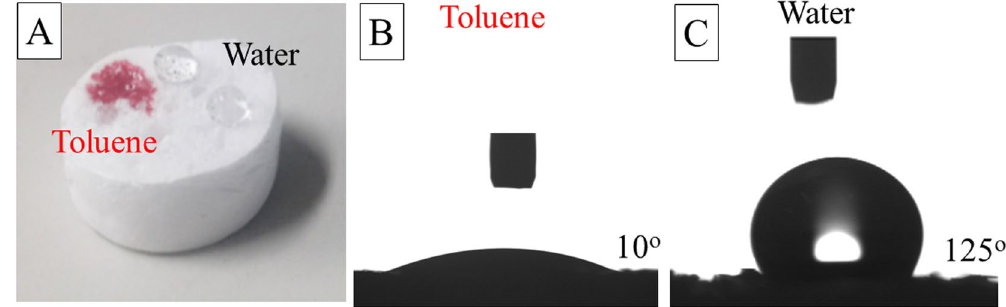
Figure 3. Droplets of toluene and water on the top of a PS monolith ( A ); the oil ( B ) and water ( C ) contact angles of the monolith.